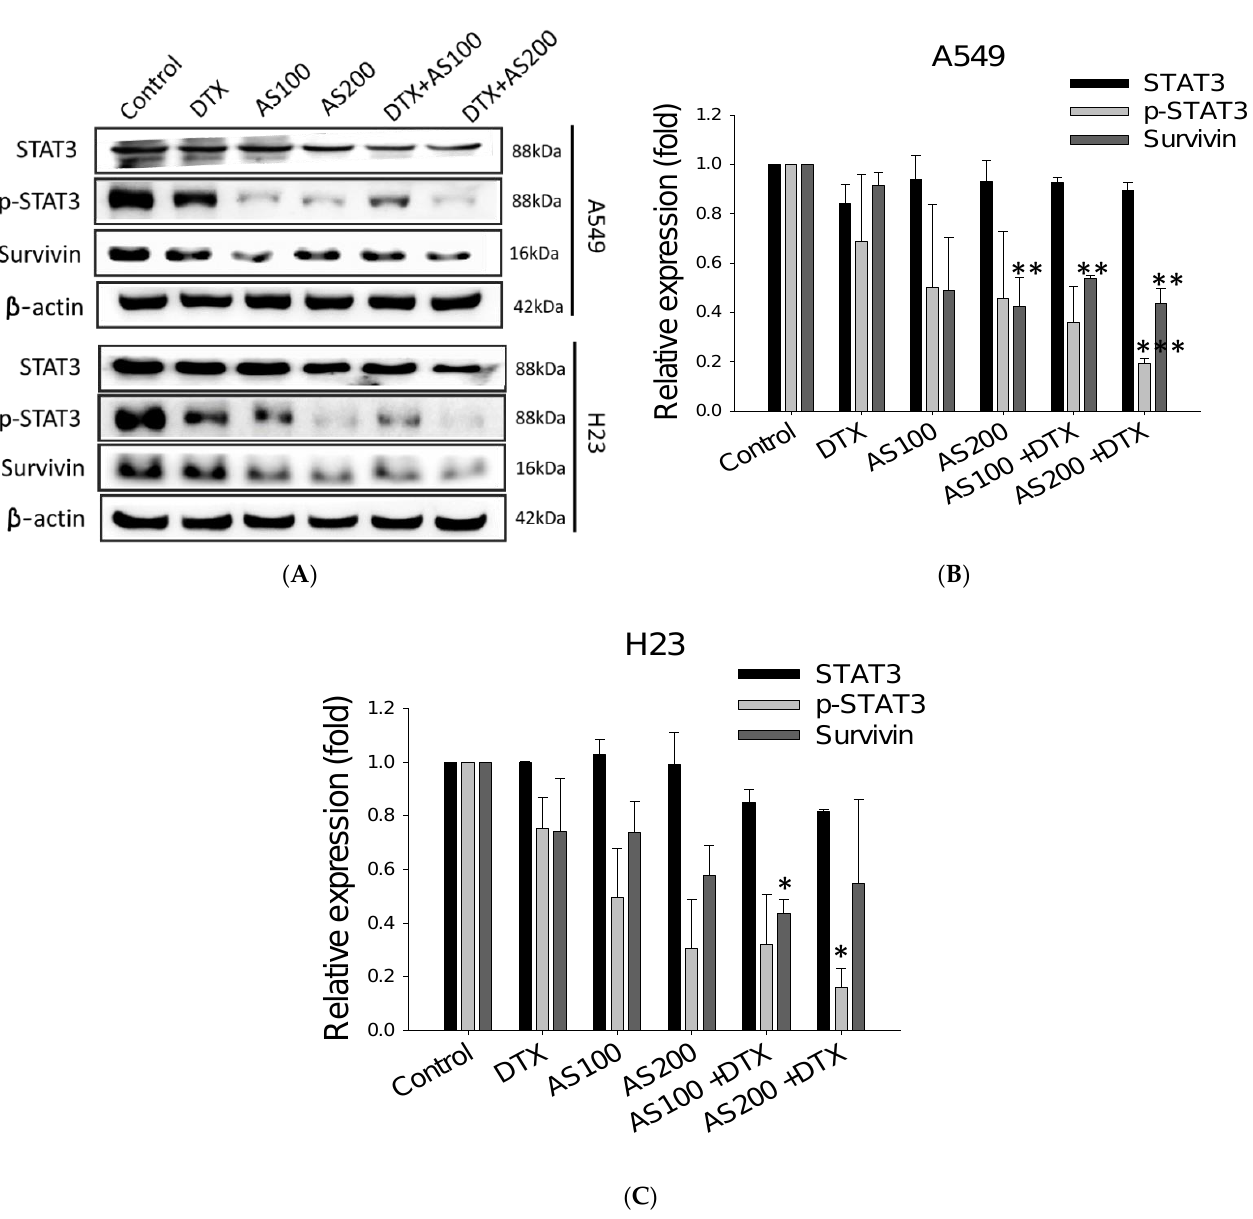
Figure 4. Synergizing effect of AS and DTX on the expressions of STAT3/survivin signaling. A549 and H23 cells were treated with AS (100, 200 μg/mL) and DTX (0.5 nM) alone or the two-drug combination for 48 h: ( A ) STAT3, p-STAT3, and survivin proteins levels were investigated. Western immunoblotting was performed and β-actin was used as loading control; ( B , C ) representative histograms of corresponding quantitative analyses. Data are the mean ± SE; * p < 0.05, ** p < 0.01, *** p < 0.001 vs. corresponding control.